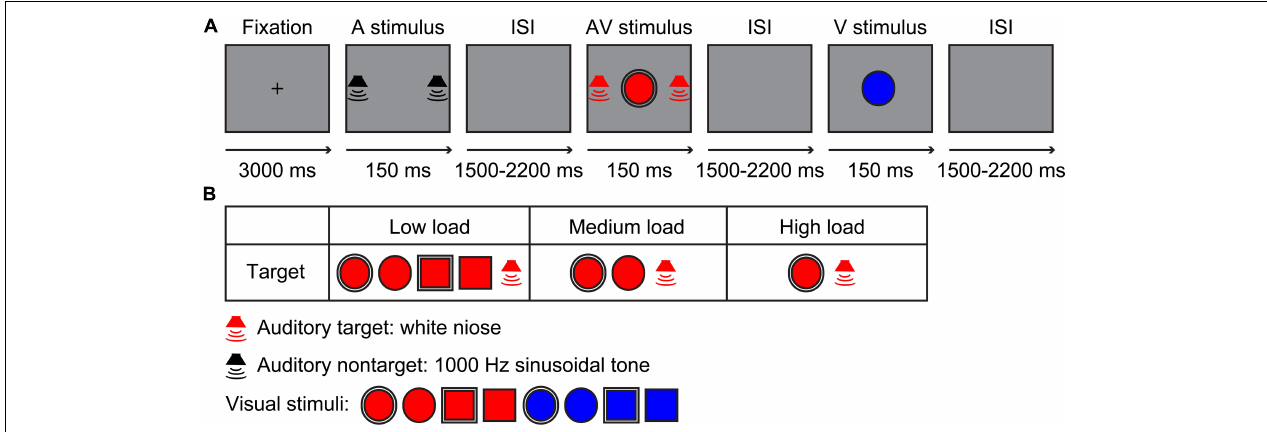
FIGURE 1 | Experimental design. (A) A possible sequence for the auditory non-target, audiovisual target, and visual non-target stimuli in the experiment. (B) Stimuli types. Low load, low visual perceptual-load condition; Medium load, medium visual perceptual-load condition; High load, high visual perceptual-load